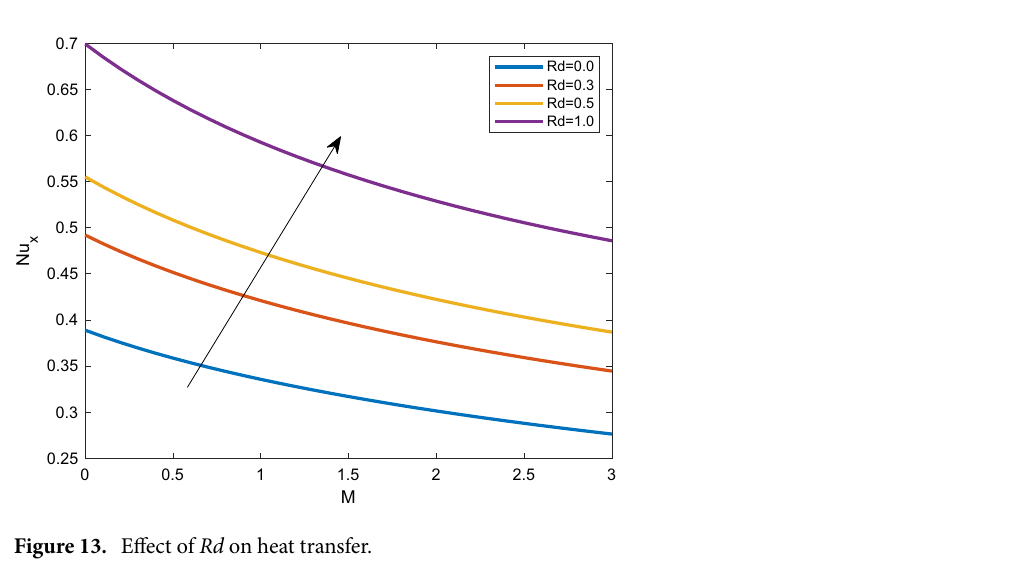
Figure 12. Inspiration γ on temperature field.